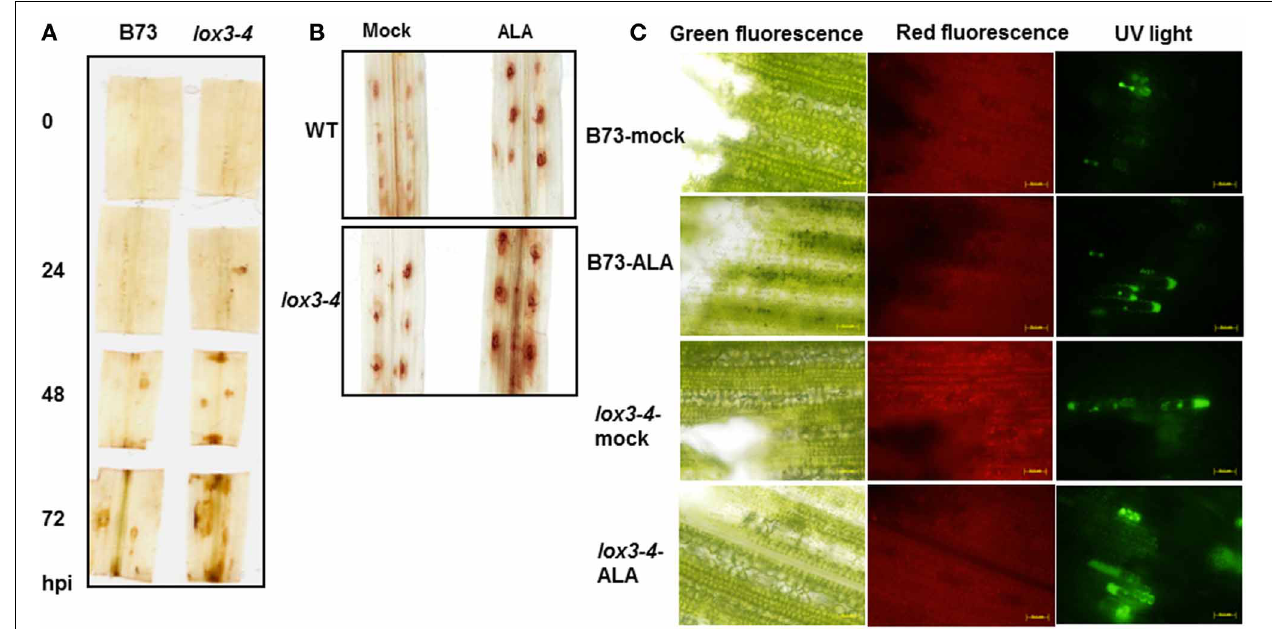
FIGURE 6 | Effect of (A) C. graminicola and (B) alamethincin (ALA) elicitor on accumulation of H2O2 or (C) Nitric Oxide in lox3-4 mutant and B73 leaves. Leaf segment from lox3-4 mutant and B73 (A) inoculated